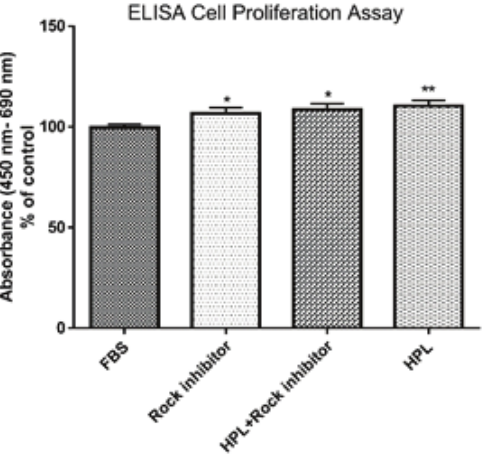
Figure 1. Cell proliferation assay. Results show a higher proliferative effect of all treatment groups as compared to the control group (* P < 0.05 and ** P < 0.01).